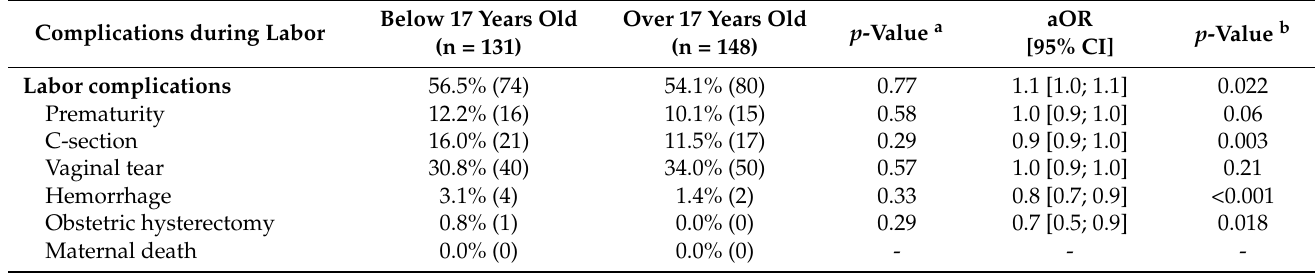
Table 4. Labor complications during pregnancy according to maternal